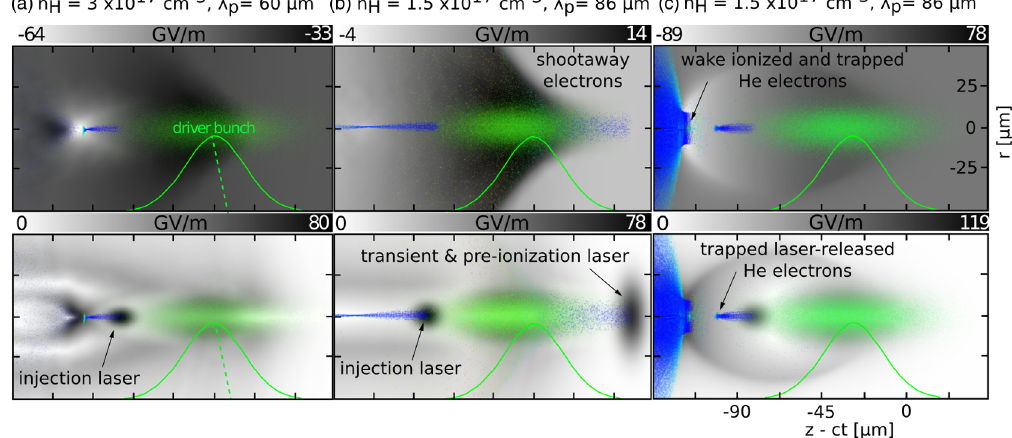
FIG. 2. Plasma generation via (a) self-field ionization, (b) partial preionization and (c) complete preionization. The top snapshots show the longitudinal electric field, and the bottom snapshots depict the total electric field, thus rendering the laser pulse(s) visible. The longitudinal current profile of the driver bunch (green) is given with the green lineout. The green dashed line in (a) indicates the effective current profile, where self-ionization begins close to the peak charge density. The laser- and wake-ionized He electrons are shown in blue